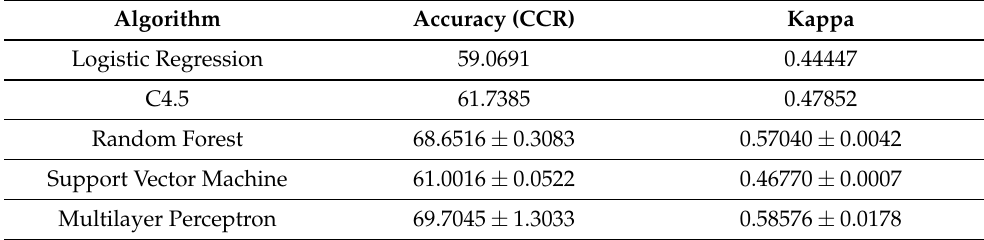
Figure 21. Final dataset opened with the environment Explorer of WEKA (waves classification). Table 4. Results (mean ± SD) obtained by the